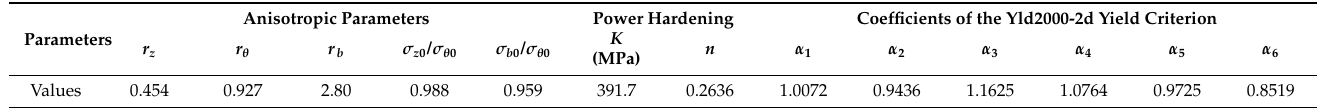
Table 1. Mechanical properties and the Yld2000-2d yield criterion of the AA6061 tube (Adapted from [43]).